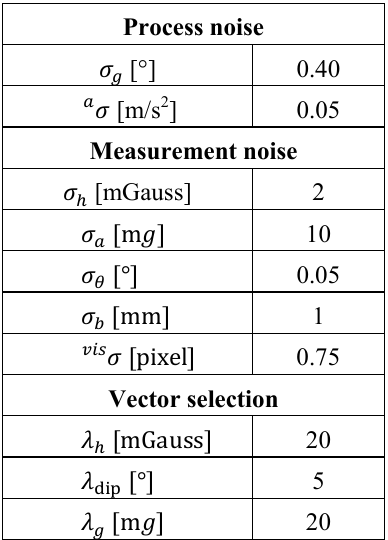
Table 1. Parameter